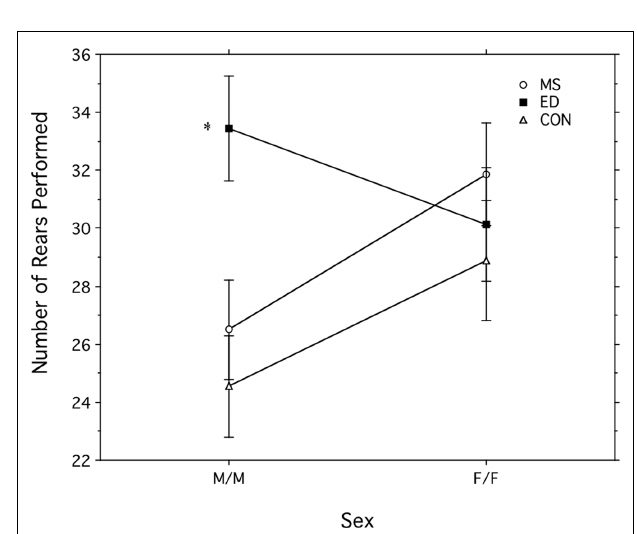
FIGURE 2 | (A) Total number of boxing bouts + SEM and (B) duration of boxing bouts in seconds + SEM in male (M/M) and female (F/F) pairs in one of three postnatal treatment condition: maternal separation (MS), early deprivation (ED), or control. *Significantly different from all other groups.